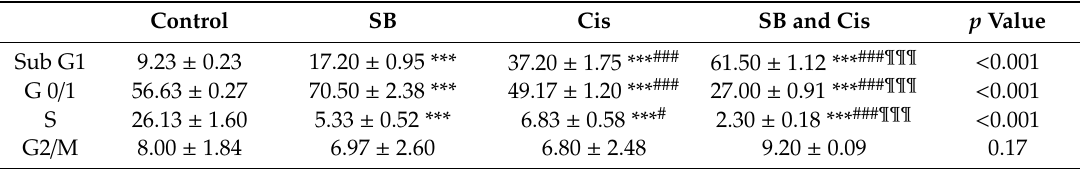
Table 4. Statistical analysis of PI positive staining detected by flow cytometry in